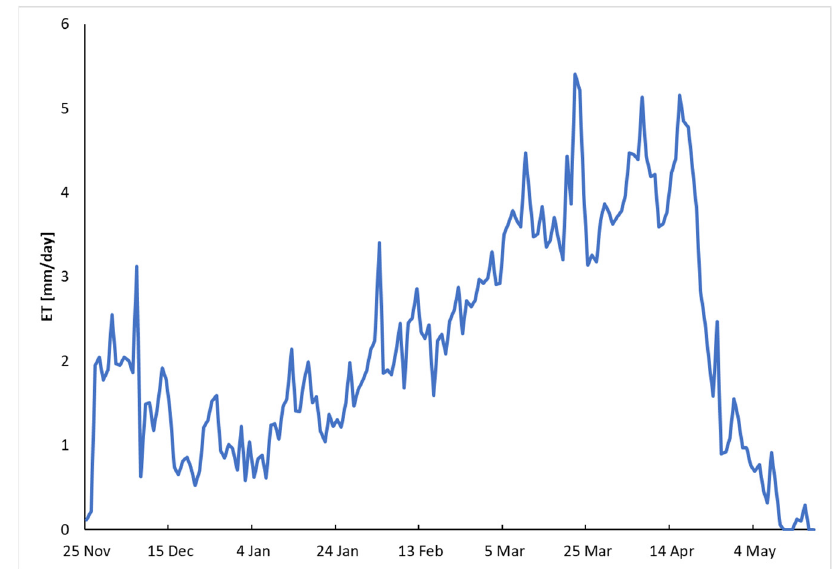
Figure 6. Daily actual evapotranspiration (ET) for wheat at Sids Research Station.